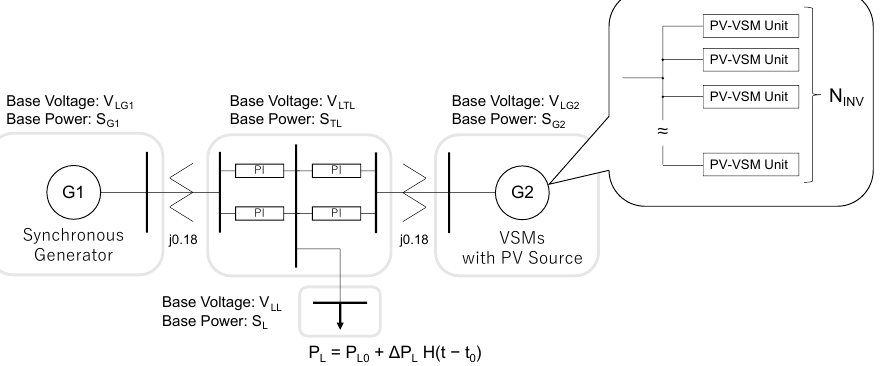
Figure 5. Schematic of the two generator system